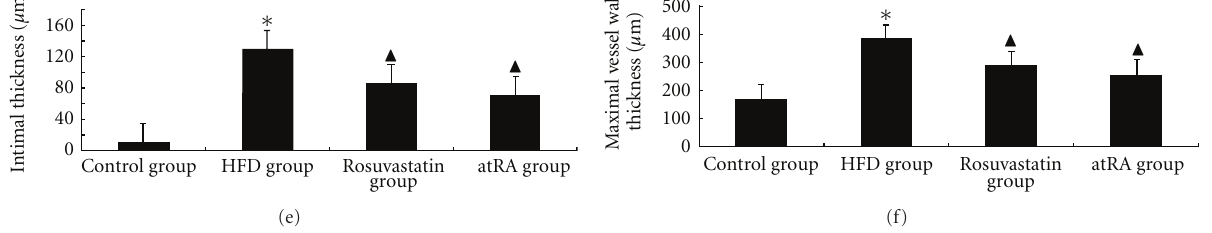
Figure 1: Characteristics of arterial lesions. Pathological sections of arterial lesions were examined by HE staining in di ff erent groups. In the control group (a), the vessel walls were thin and smooth with even thicknesses; in the HFD group (b), there were more foam cells and necrotic substances in the intima. Compared with the HFD group, there were less foam cells, necrotic substances in the intima from rosuvastatin group (c) and atRA group (d) (magnification × 200). Statistical results of aortic intimal thickness (e) and maximal vessel wall thickness (f) among di ff erent groups; ∗ P < 0 . 05 compared to control group, (cid:2) P < 0 . 05 compared to HFD